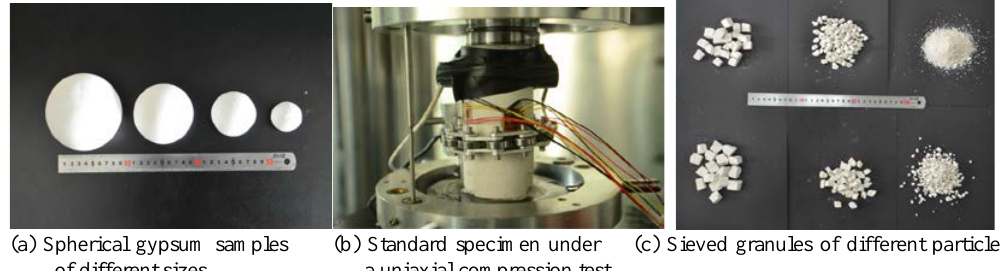
Figure 2. Experimental material production and testing process.